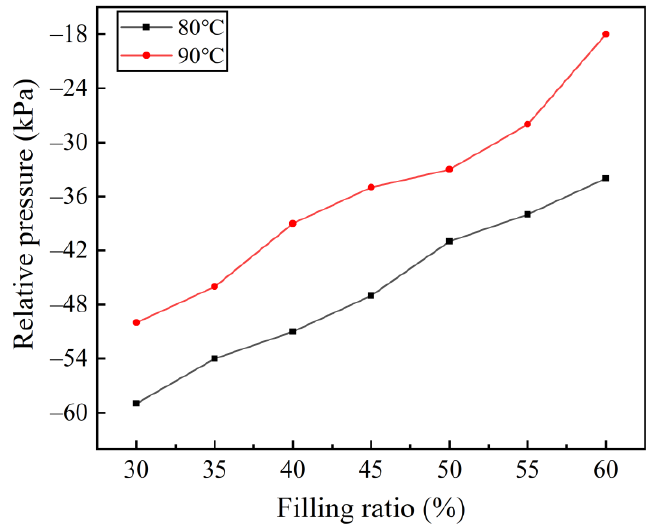
Figure 3. Relative pressure versus different filling ratios at 80 °C and 90 °C .